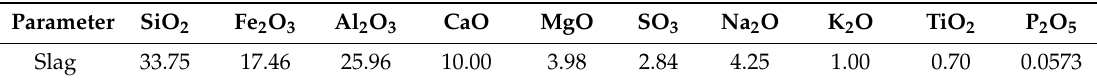
Table 2. Compositions of the slag after additional thermal treatment (in weight percentages, wt.%). Parameter SiO